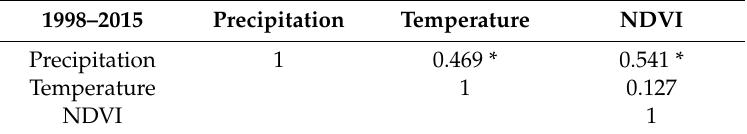
Table 2. Spearman’s correlation coe ffi cients for the NDVI, precipitation, and temperature in NXC.